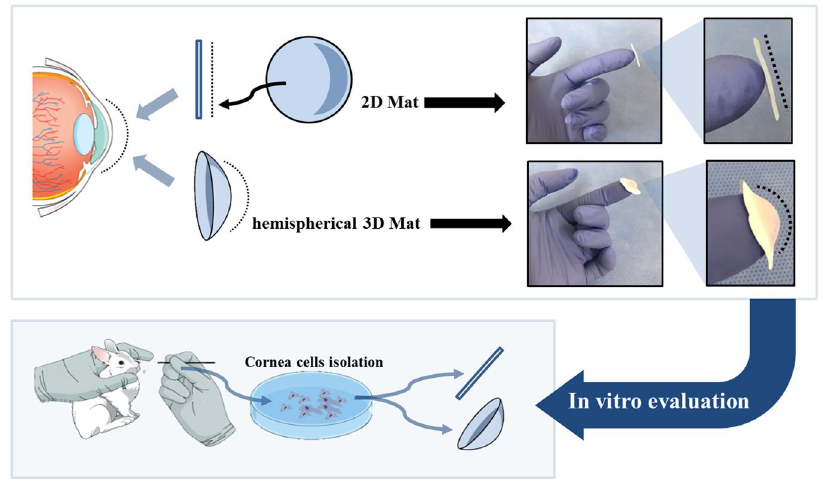
Figure 1. Illustration of the shape comparison of 3D and 2D nanofibrous scaffolds and experimental